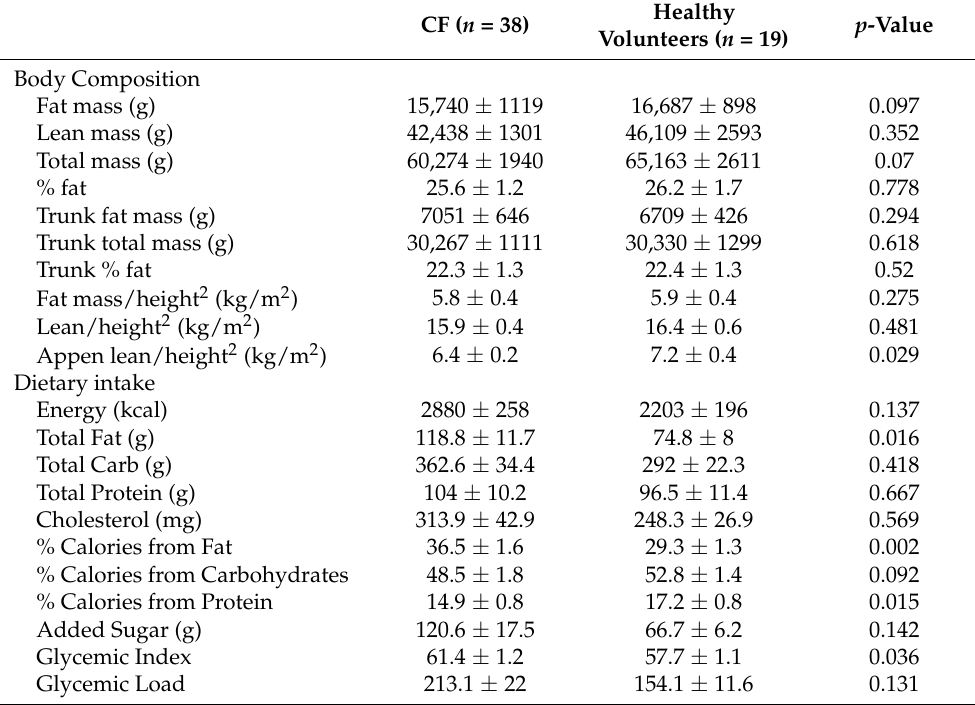
Table 2. Body composition and dietary intake in participants with CF and healthy volunteers.